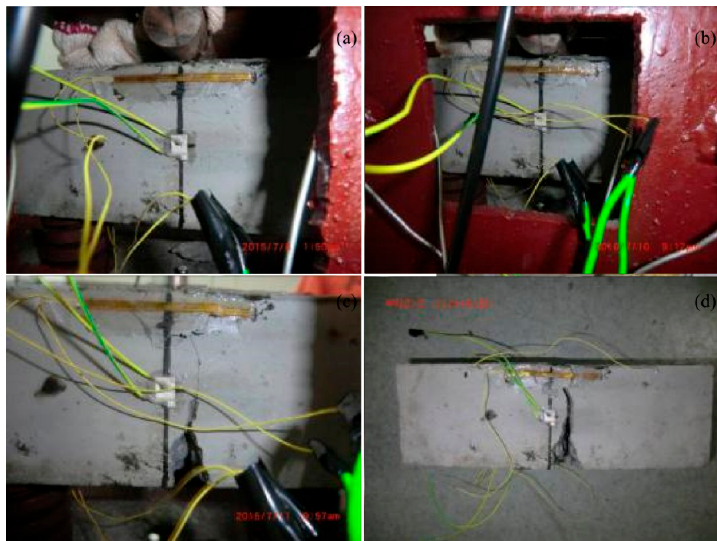
Figure 13. Damage state of the inverted arch structure at different stages: ( a ) initial stage, ( b ) intermediate stage, ( c ) failure stage, and ( d ) cracking position.